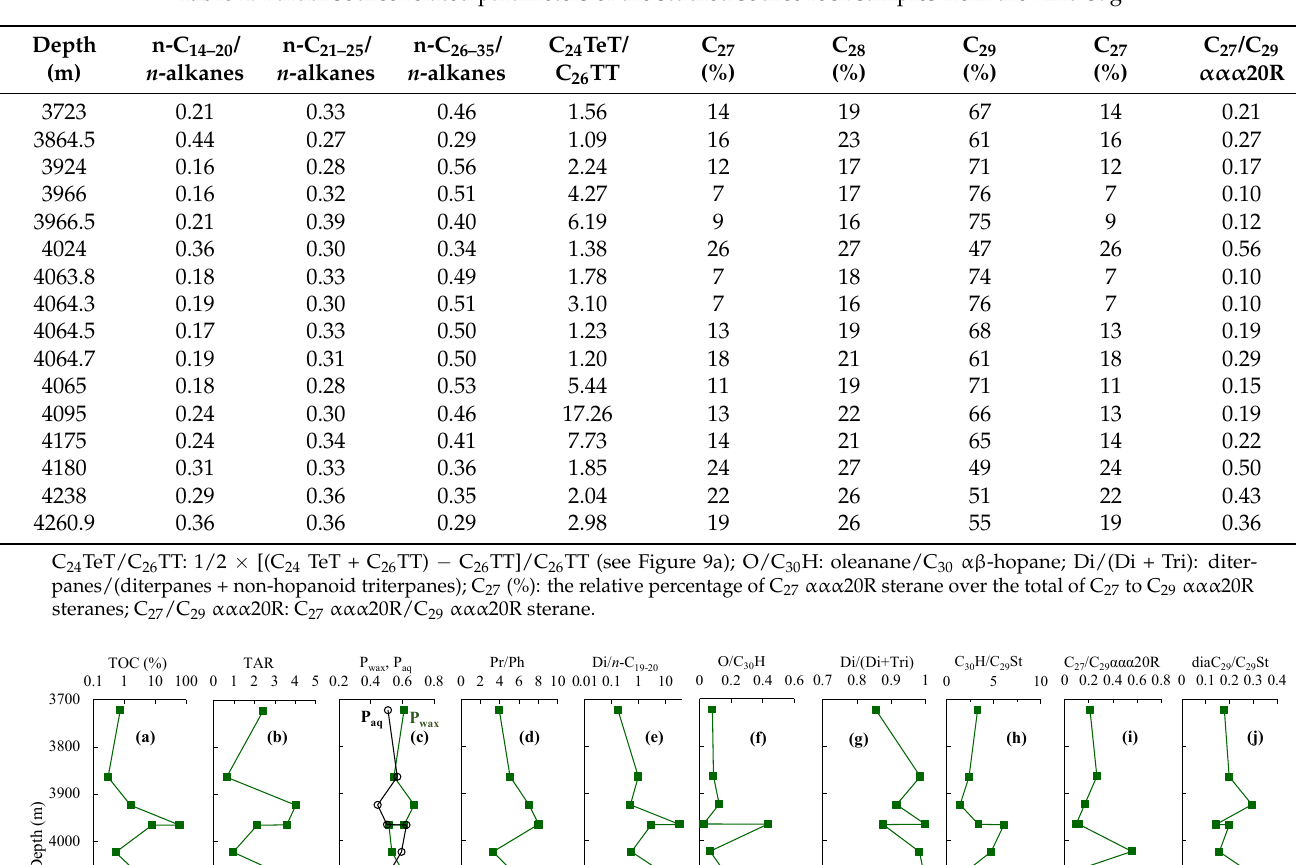
Table 2. Partial source related parameters of the studied source rock samples from the Xihu Sag.